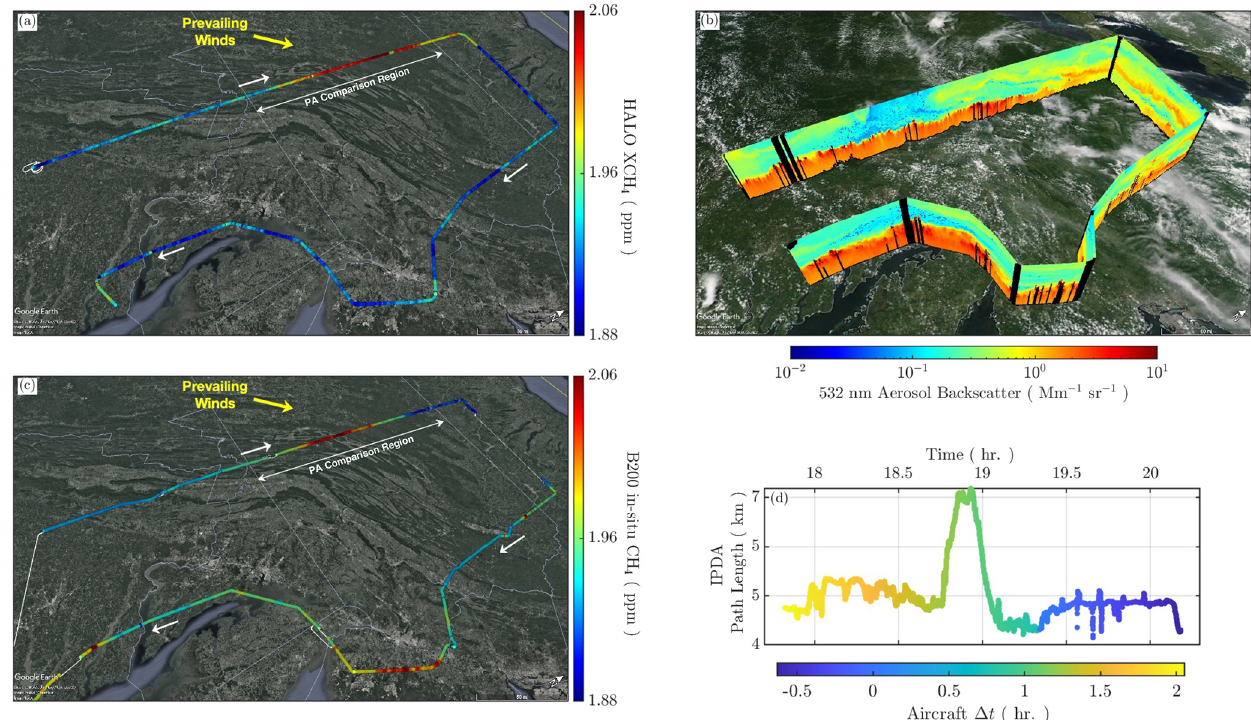
Figure 12. Comparisons between HALO’s column XCH 4 from the C-130 and in situ PBL CH 4 from the B200 during the second leg of the 20 July flight. (a) Cloud-cleared HALO XCH 4 retrievals (©Google Maps). (b) HSRL-derived aerosol backscatter at 532nm with an overlay of the TERRA MODIS corrected reflectance to indicate cloud extent (©Google Maps). (c) In situ sampled CH 4 restricted to the PBL (the B200 aircraft landed for refueling, ∼ 18.5–19.25) (©Google Maps). (d) IPDA path length with the C-130 and B200 temporal